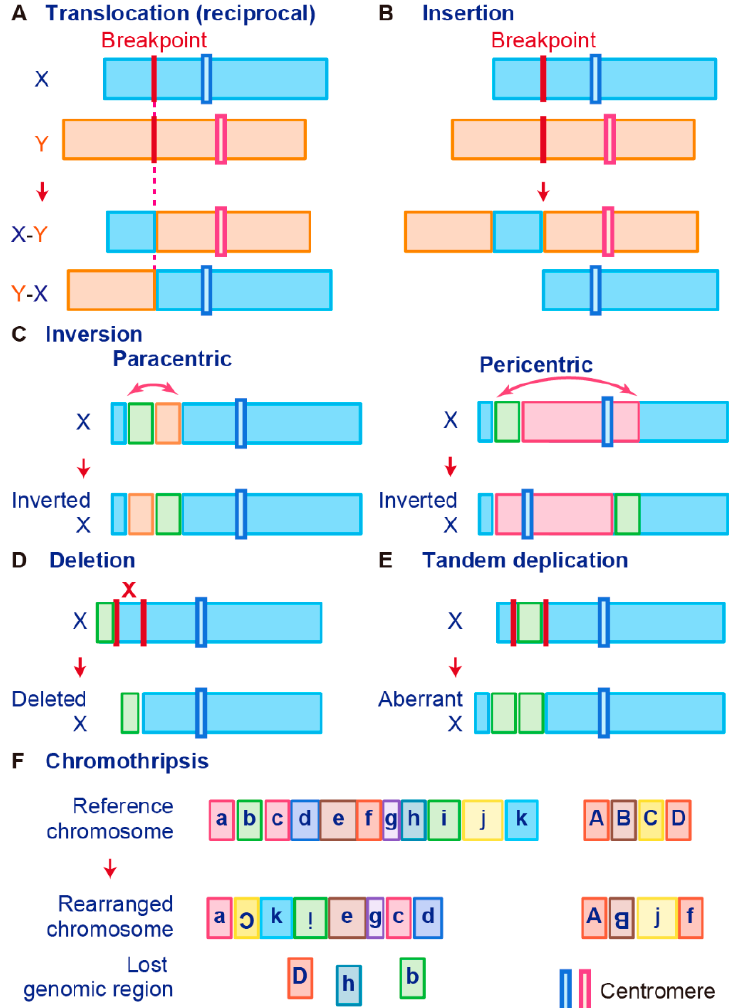
Figure 1. Schematic representation of fusion gene formation by structural chromosome rearrange- ments. ( A ) Translocation. ( B ) Insertion. ( C ) Inversion. ( D ) Deletion. ( E ) Tandem duplication. ( F ) Chromothripsis.